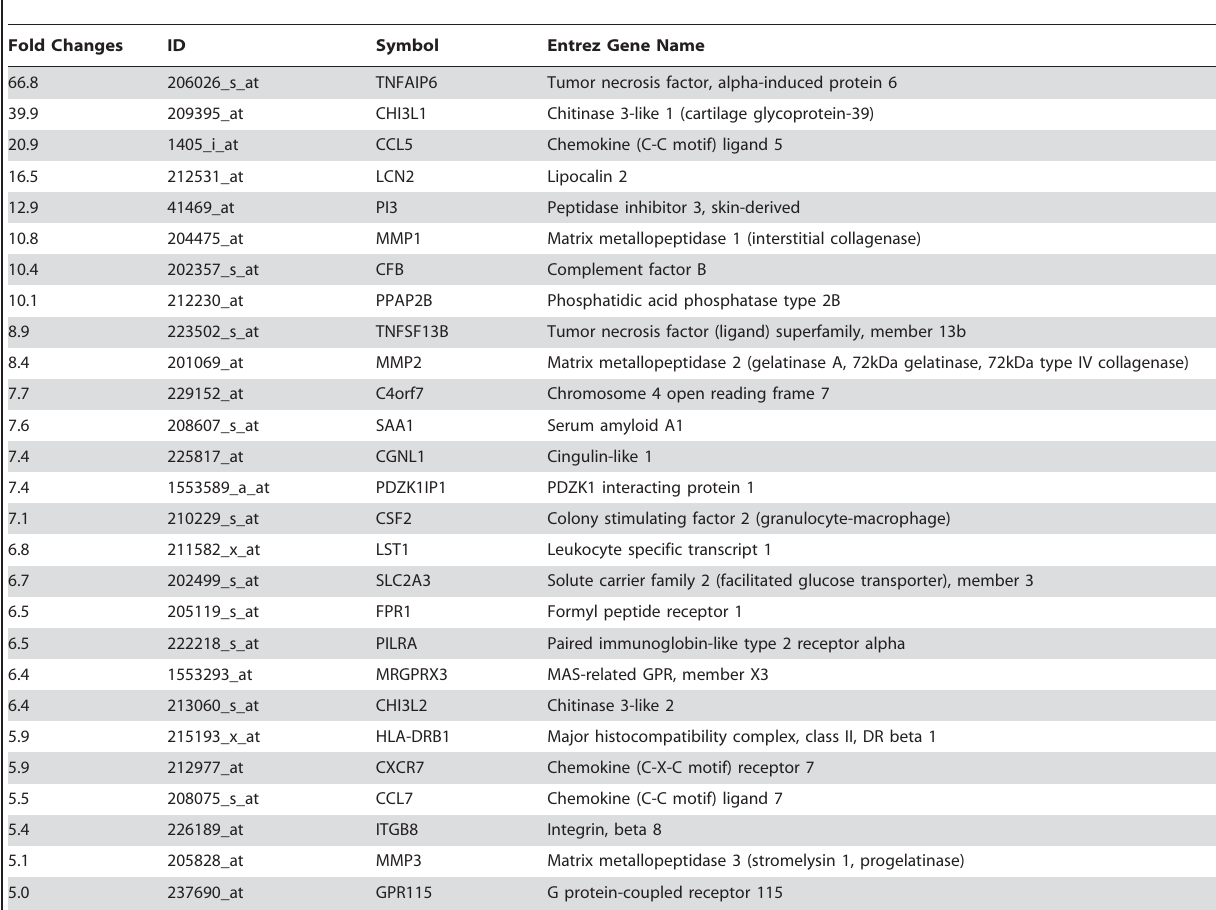
Table 3. Genes differentially expressed in cell membrane between NCI-H226 spheroids and monolayers.